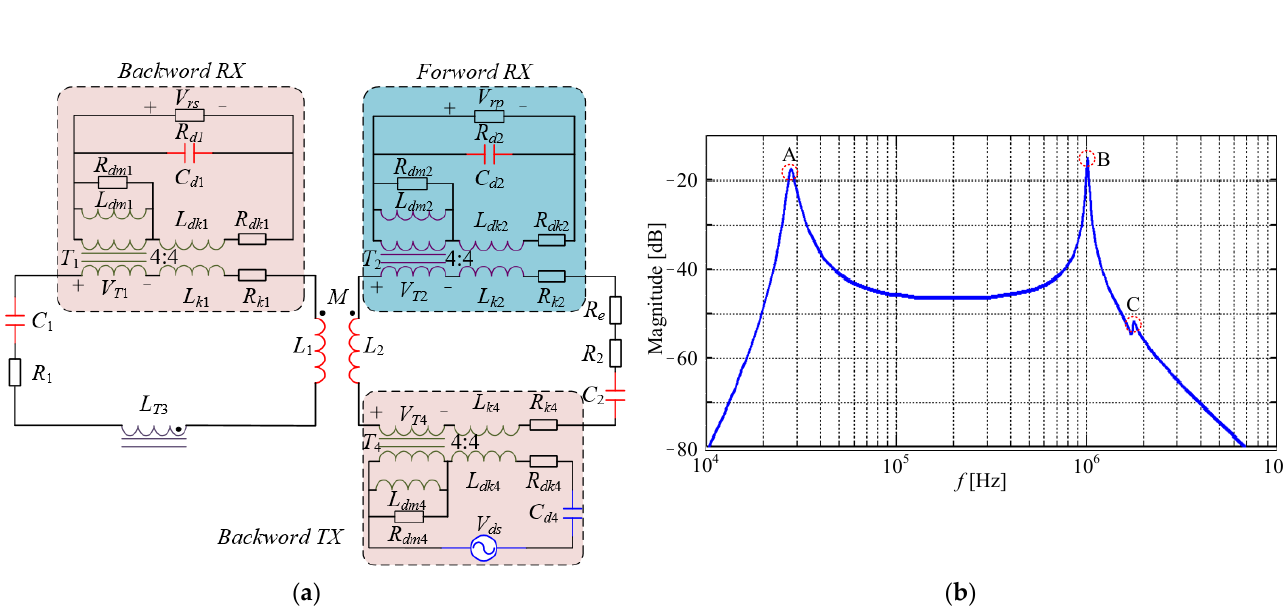
Figure 6. Backward information transfer channel. ( a ) Simplified schematic of the backward transmission channel. ( b ) Bode diagram of the backward information transmission.